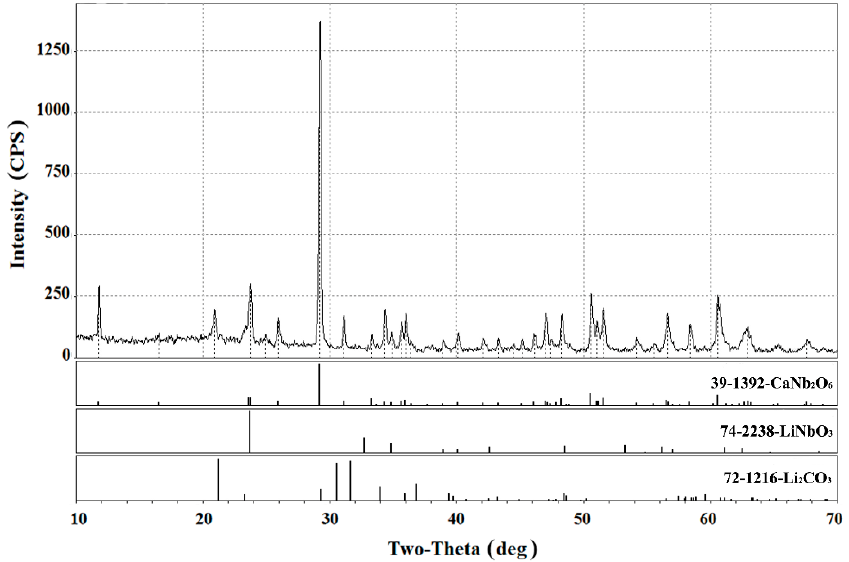
Figure 6. X-ray diffractogram of the heterovalent ionic exchange reaction products after holding lithium niobate in a molten mixture of lithium and calcium chlorides at 700 °C for 5 h. lithium niobate in a molten mixture of lithium and calcium chlorides at 700 ◦ C for 5